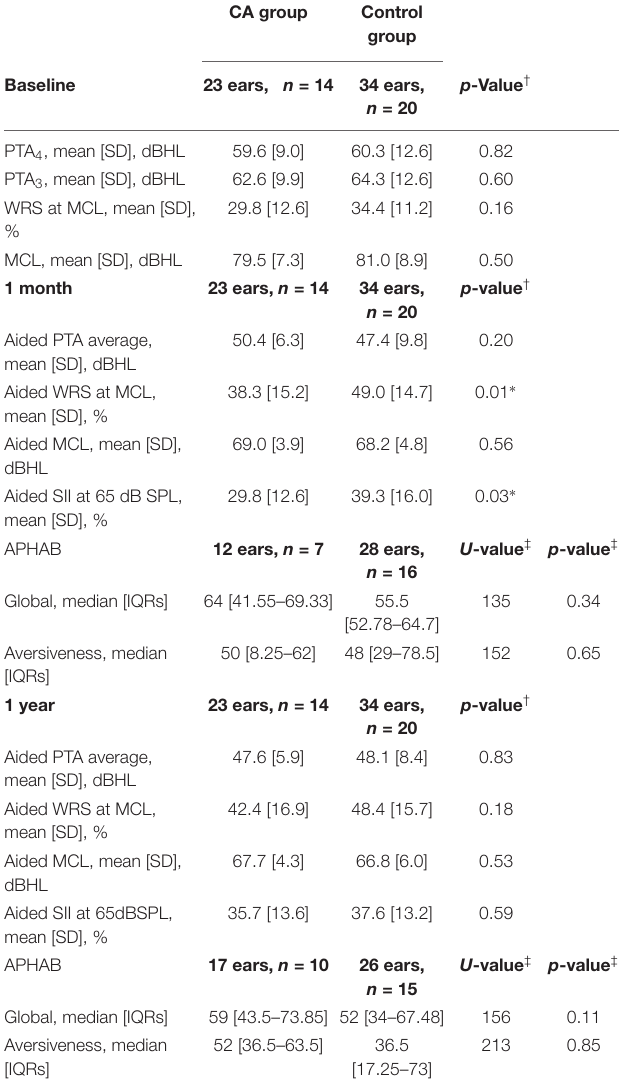
TABLE 2 | Audiological